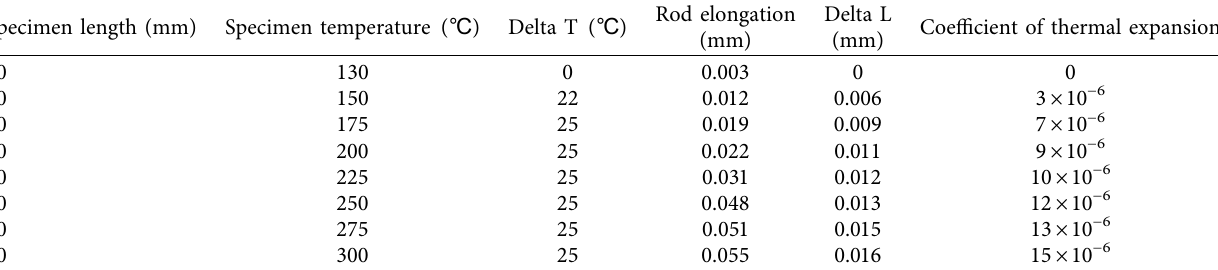
Table 11: CTE of the Ni-Cu alloy+ 6% TiO